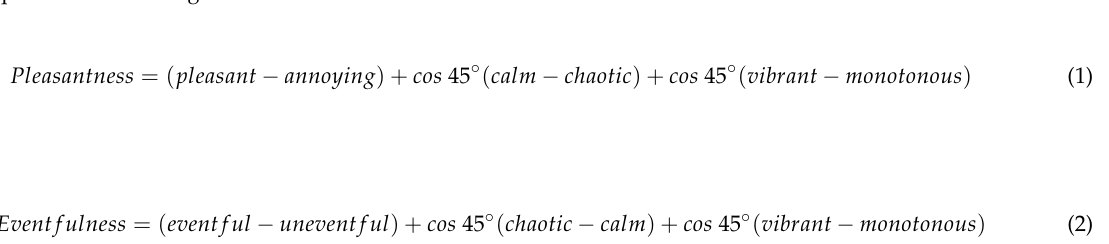
Table 1 points at some direct translations consistent